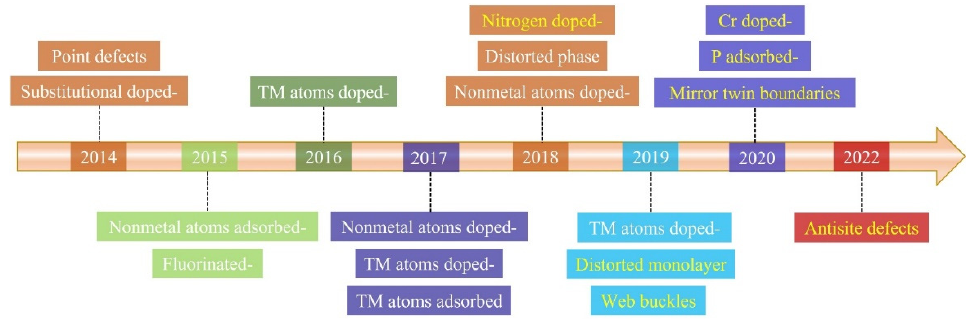
Figure 1. Timeline showing key developments of RTFM in ReS 2 . White font represents the theoretical progress; yellow font represents the experimental progress.